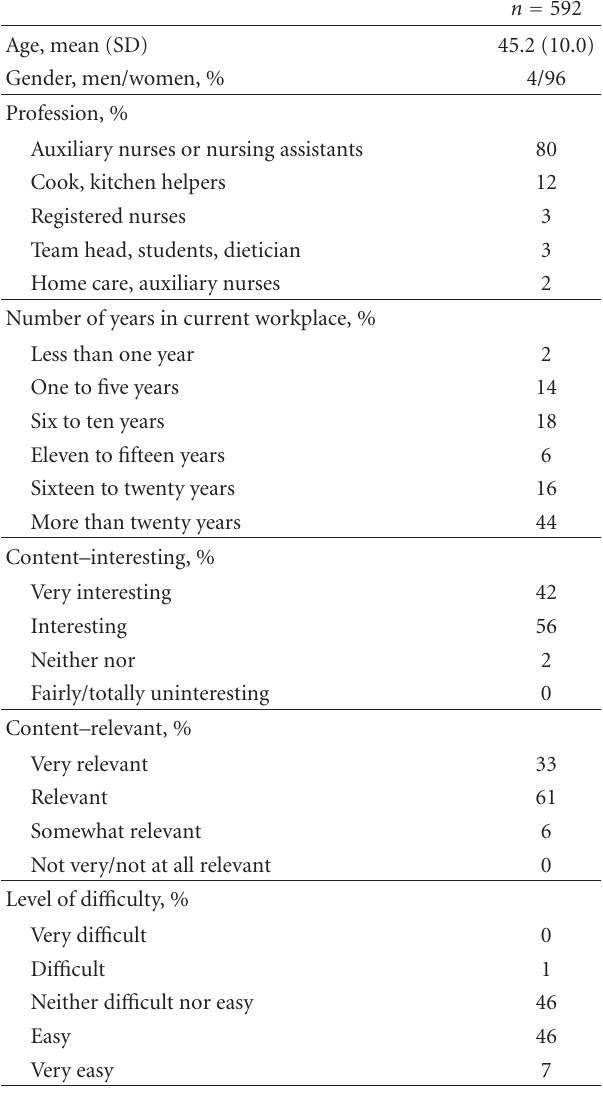
Table 1: Number of study circles and participants every six months. Period